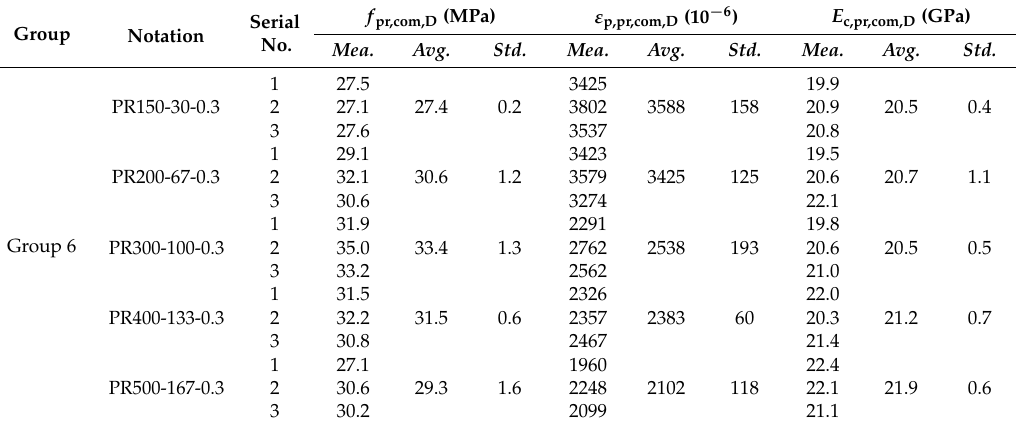
Table 7. Experimental results of specimens in Group